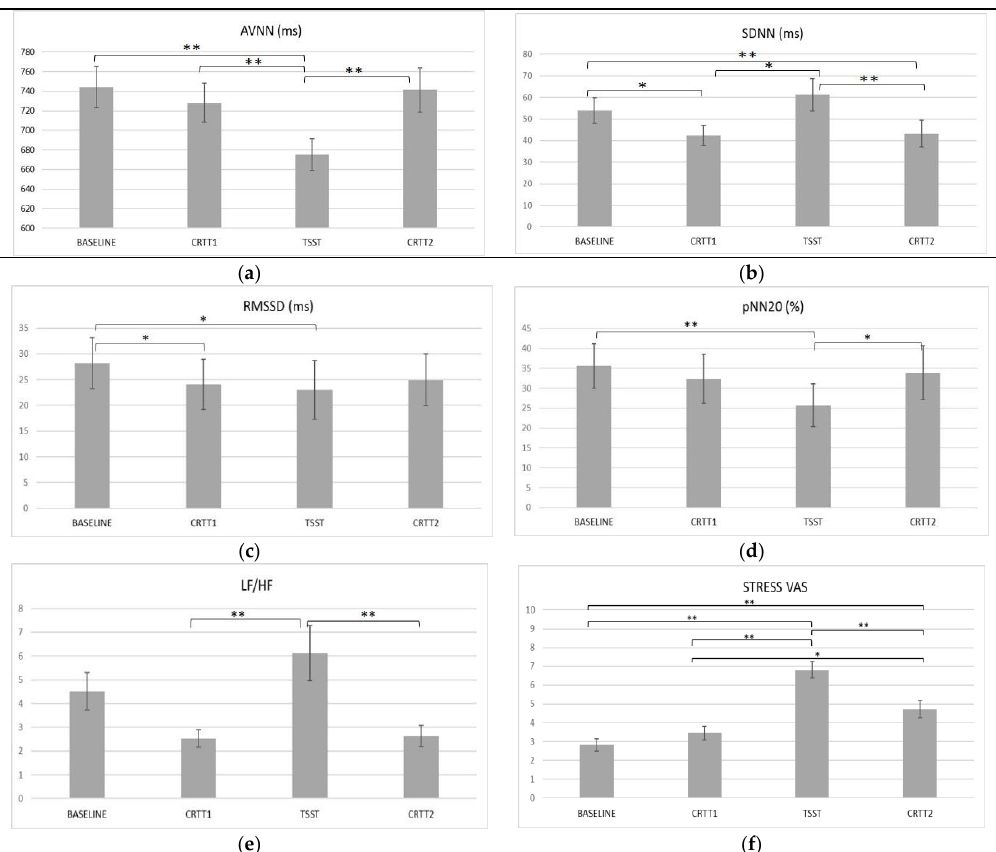
Figure 5. Mean statistical significant differences for electrocardiogram (ECG)-derived measures—( a ) Average of normal-to-normal intervals (AVNN); ( b ) Standard Deviation of all NN (SDNN); ( c ) root mean square of differences between successive rhythm-to-rhythm (RR) intervals (RMSSD); ( d ) pNN20; ( e ) LF/HF and subjective stress measures—and, ( f ) VAS across study time points ( p < 0.01; Friedman test). * p < 0.05; ** p < 0.01; *** p < 0.001 for post-hoc pairwise comparisons.